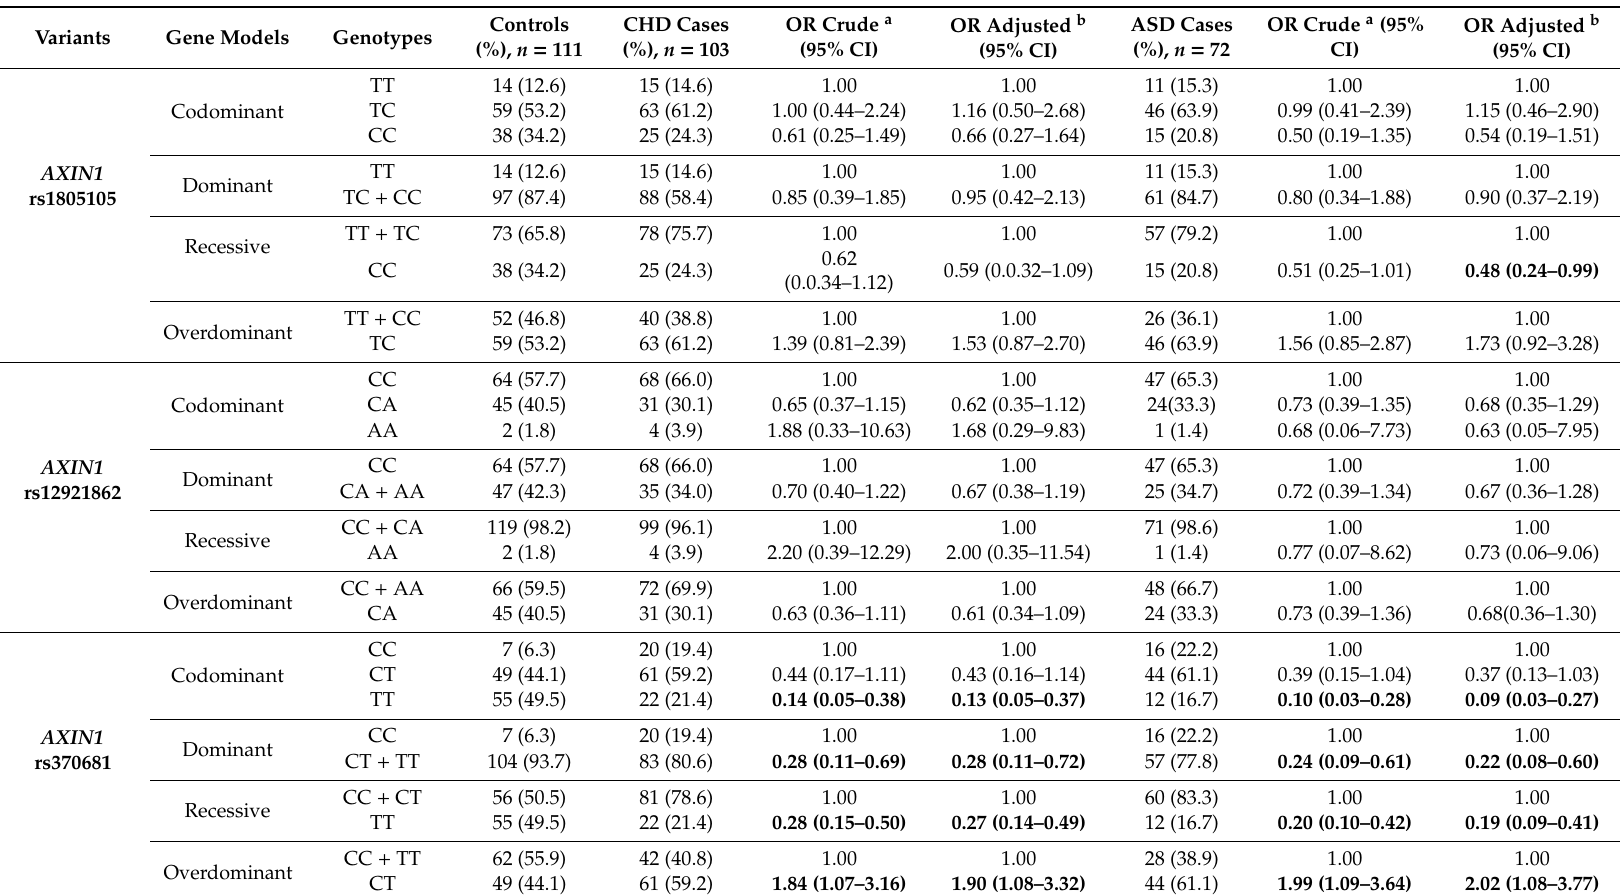
Table 1. Genotypes distribution and their associations with odds of CHD /